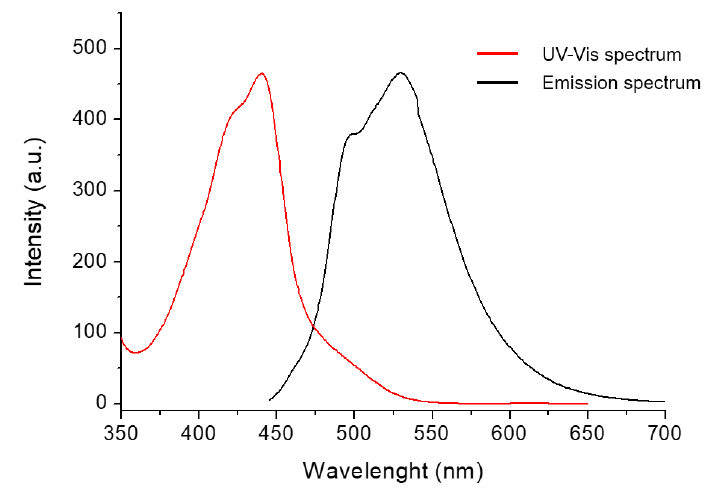
Figure 3. Normalized UV-vis (in red) and emission spectra (in black, λ ex 440 nm) of 2 in CHCl 3 (1 × 10 − 6 M).